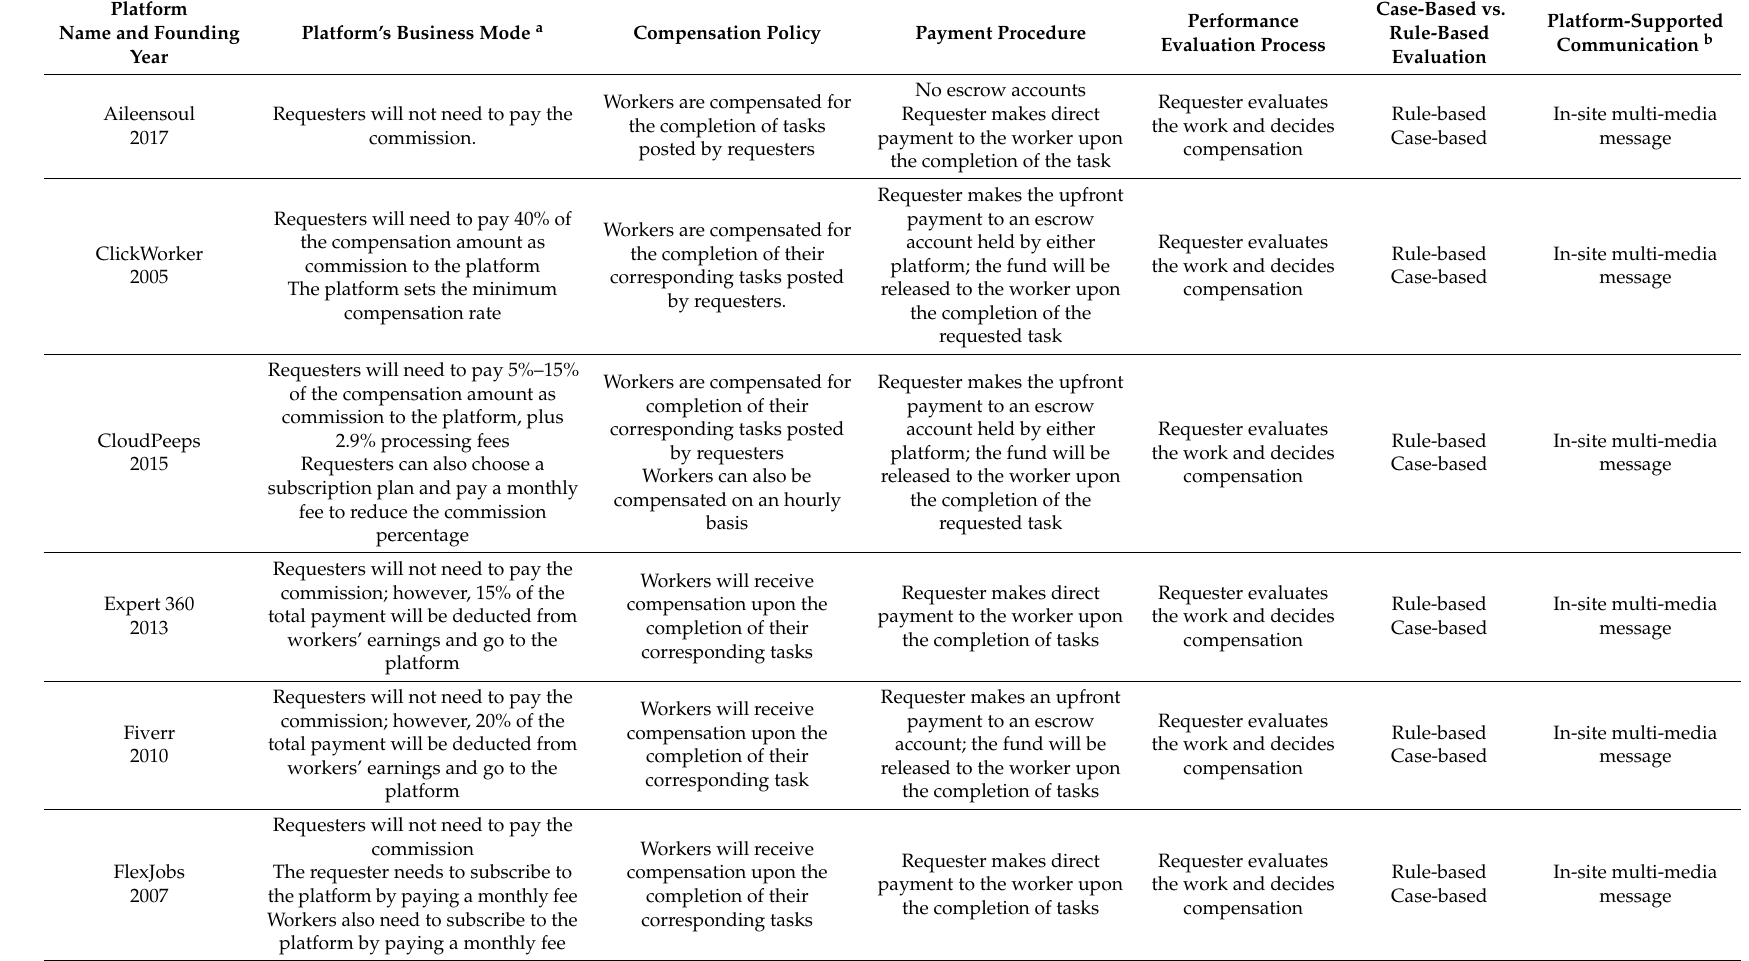
Table 2. Summary of Extant Crowd-based General Labor Platforms (in the alphabetical order) a